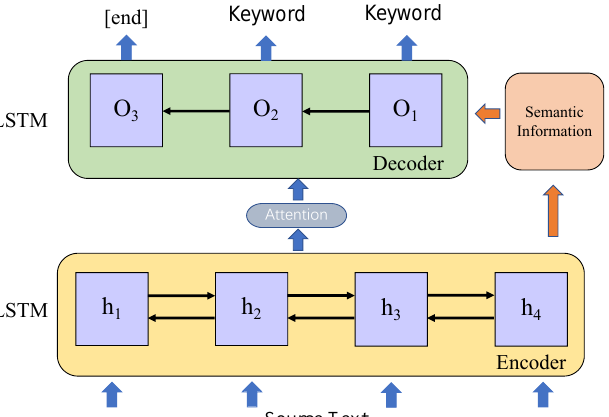
Figure 4. Keyword-extraction model. We introduced a BiLSTM and an attention mechanism to perform keyword-extraction